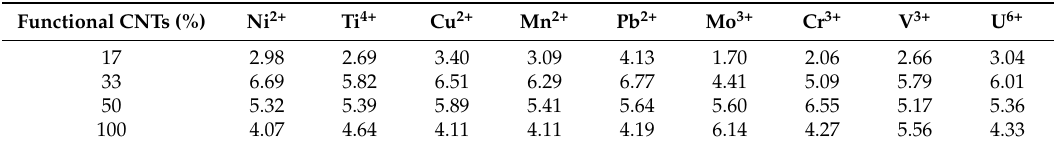
Figure 5. Change in recovery of environmental ion contaminants against different functional CNT bead samples. Table 3. Environmental ion contaminants recovery ( q e ) (mg/g) using different functional CNT content conjugates.